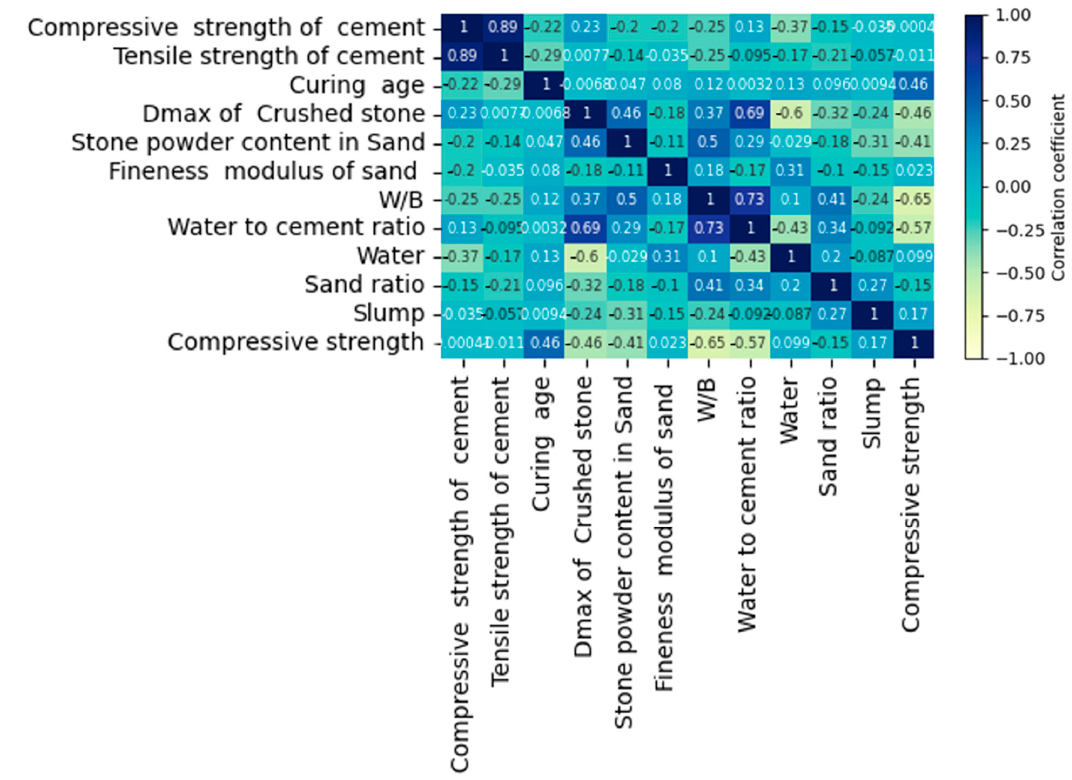
Figure 4. Correlation coefficient matrix of each variable in the MSC dataset.